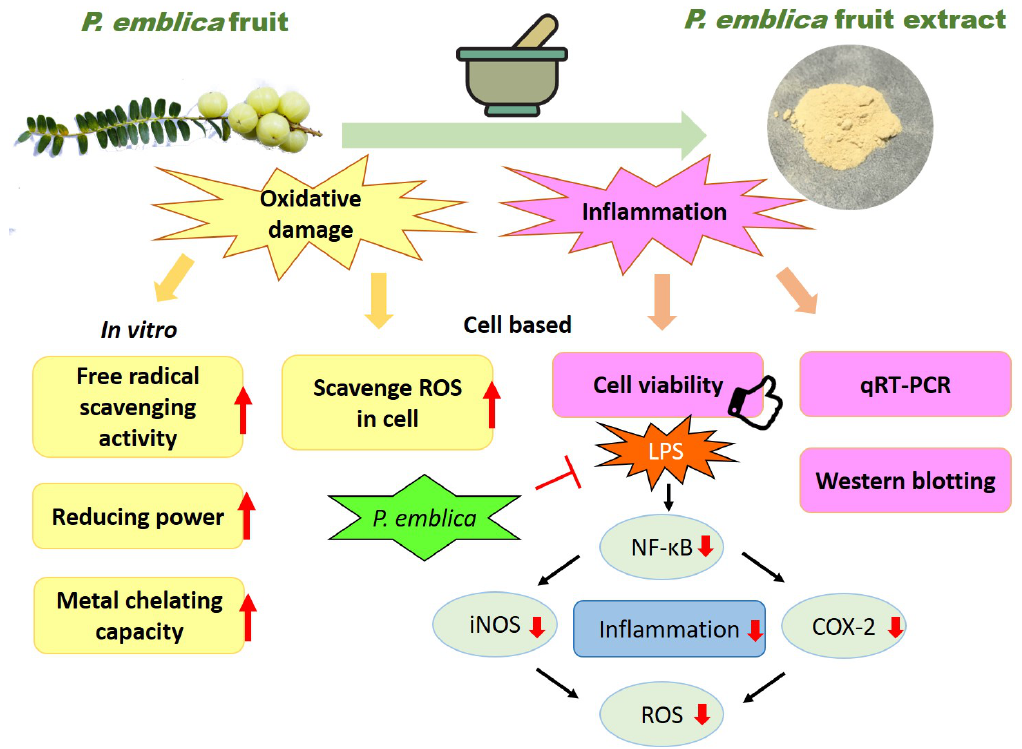
Figure 5. The cartoon illustration of antioxidation and anti-inflammation mechanisms of P. emblica fruit extract